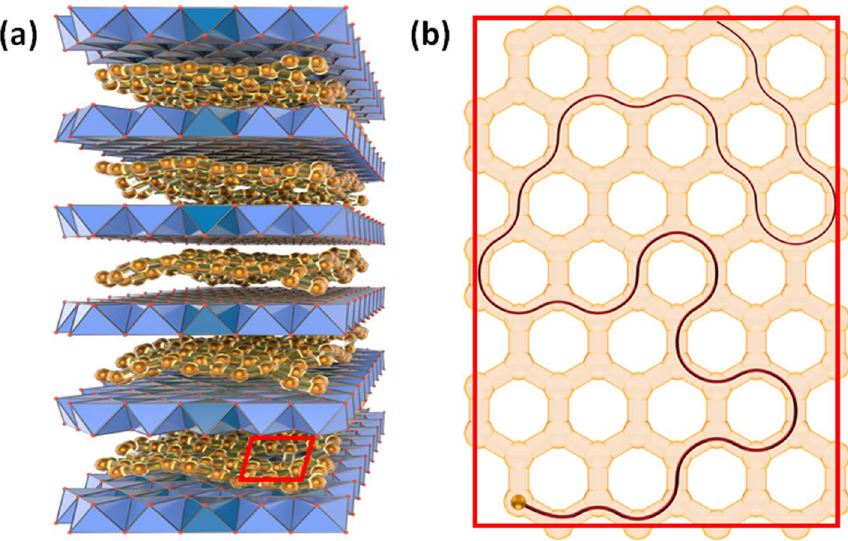
Figure 1. ( a ) A schematic representation of the structure of exemplar honeycomb layered materials A 4 MD O 6 , A 3 M 2 D O 6 or A 2 M 2 D O 6 wherein A represents an alkali ion (Li, Na, K, etc .) or coinage metal ions such as Ag, whereas M is mainly a transition metal species such as Co, Ni, Cu and Zn, and D depicts a pnictogen or chalcogen metal species such as Sb, Bi and Te. The red rectangle at the base indicates the location of the schematic in Fig. 1b; ( b ) Schematic depicting honeycomb-shaped diffusion pathways with vacant cationic sites in exemplar honeycomb layered materials. The maroon line shows a possible random diffusion pathway of the